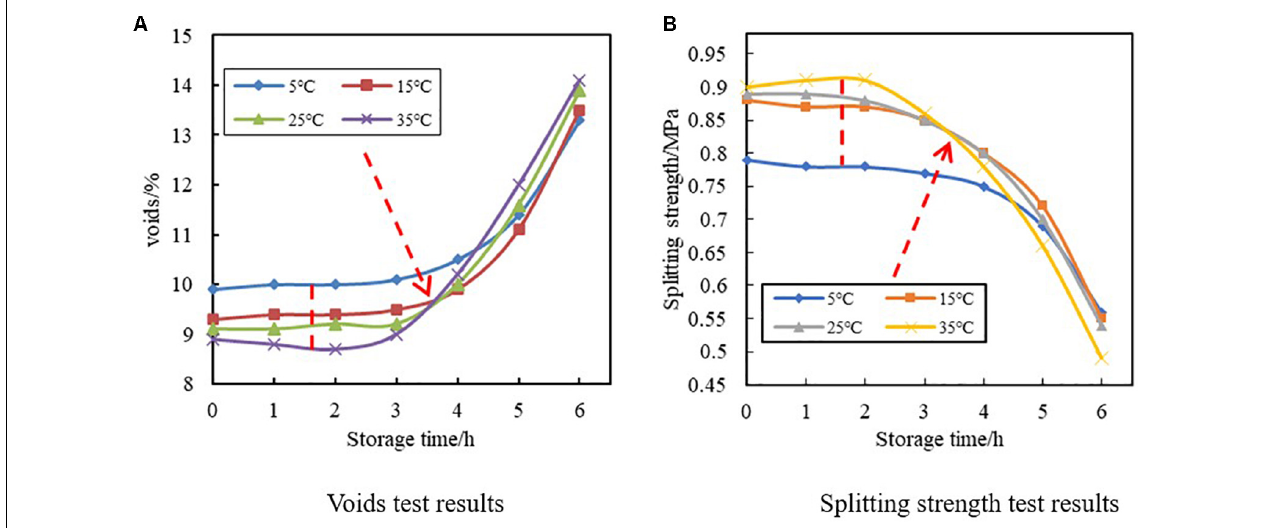
FIGURE 6 | Voids and splitting strength of cold recycled mixture under different molding temperature and curing time: (A) voids test results; (B) splitting strength test results.